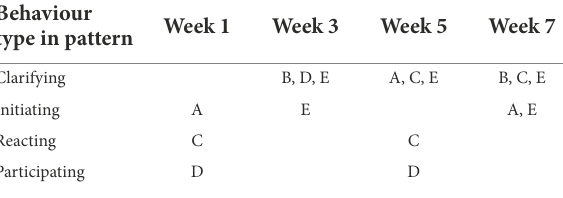
TABLE 4 Singer behaviour types occurring in patterns, by week. Behaviour type in